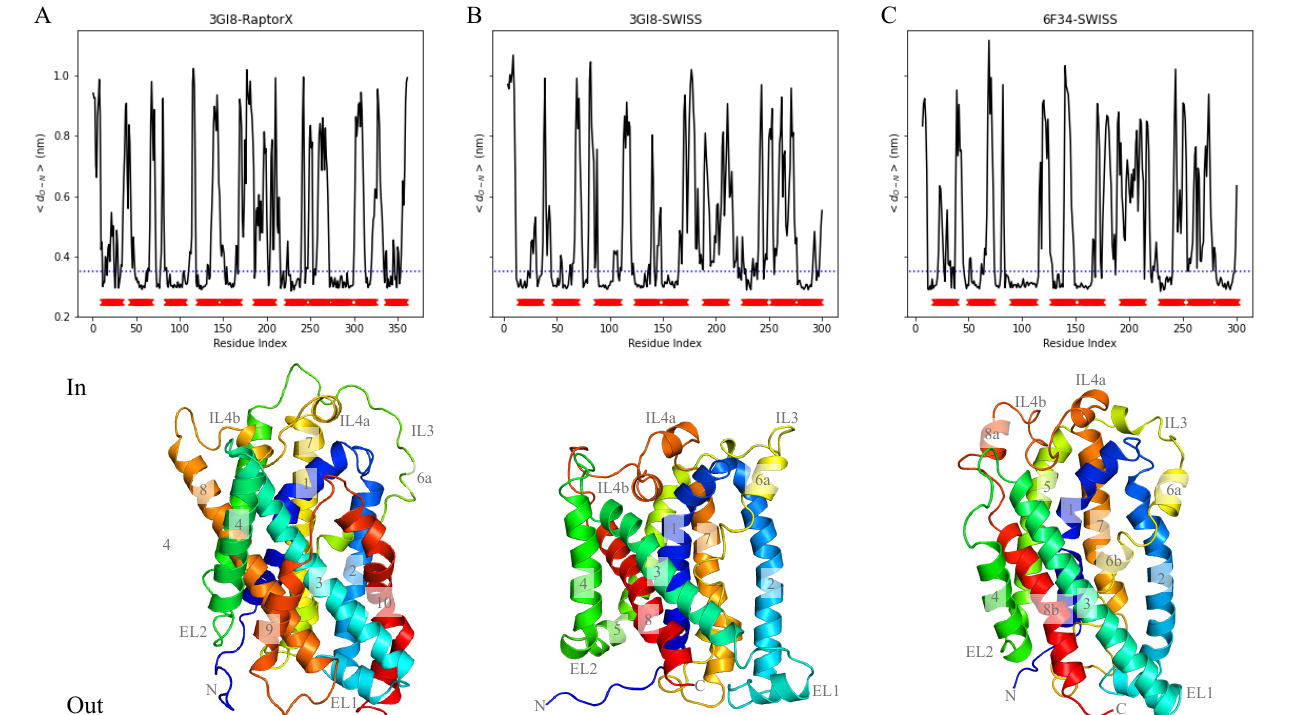
Figure 3. Structure of GerAB models. ( A ) shows the helicity and structure of the 3GI8-RaptorX model [25], with the colors indicating the helical regions as defined in Figure 2. ( B ) depicts the helicity and structure of the 3GI8-SWISS model [25]. ( C ) shows the helicity and structure of 6F34-SWISS model [26]. The helicity is defined as the distance between the backbone oxygen atom of residue n and the backbone nitrogen atom of residue n+4. The blue line indicates a distance of 0.35 nm, the distance threshold for a hydrogen bond interaction and the red blocks indicate TM regions as defined by TMHMM/Phobius, see Uniprot entry UniProtKB-P07869 (GERAB_BACSU) [36]. Helicity per model is the average of the last 50 ns of 5